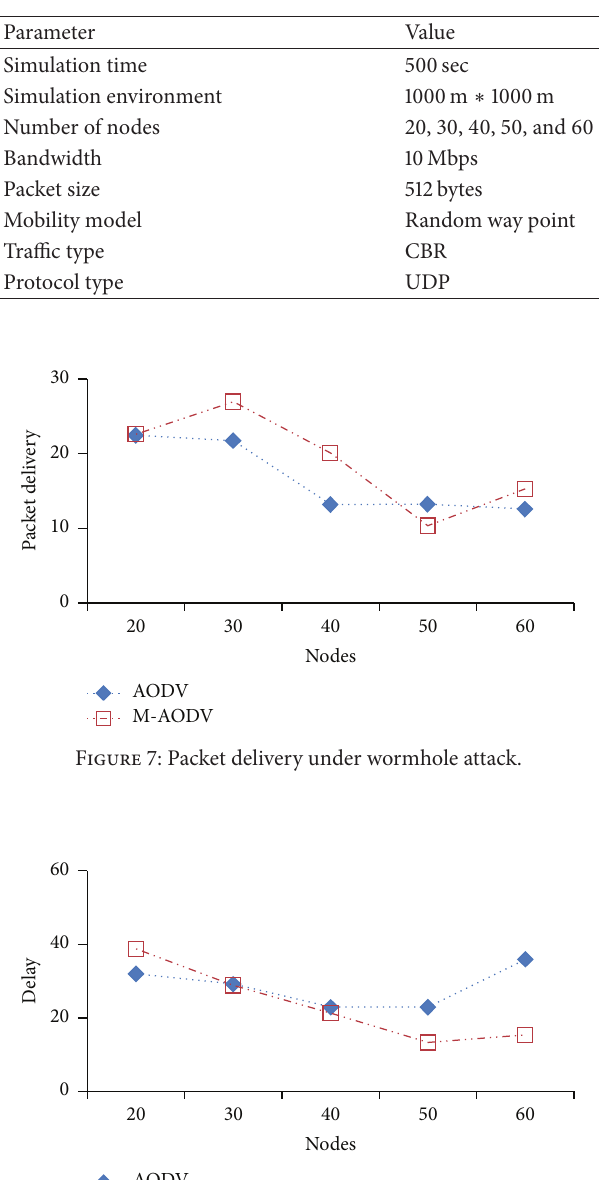
Table 4: Simulation parameters under attack.